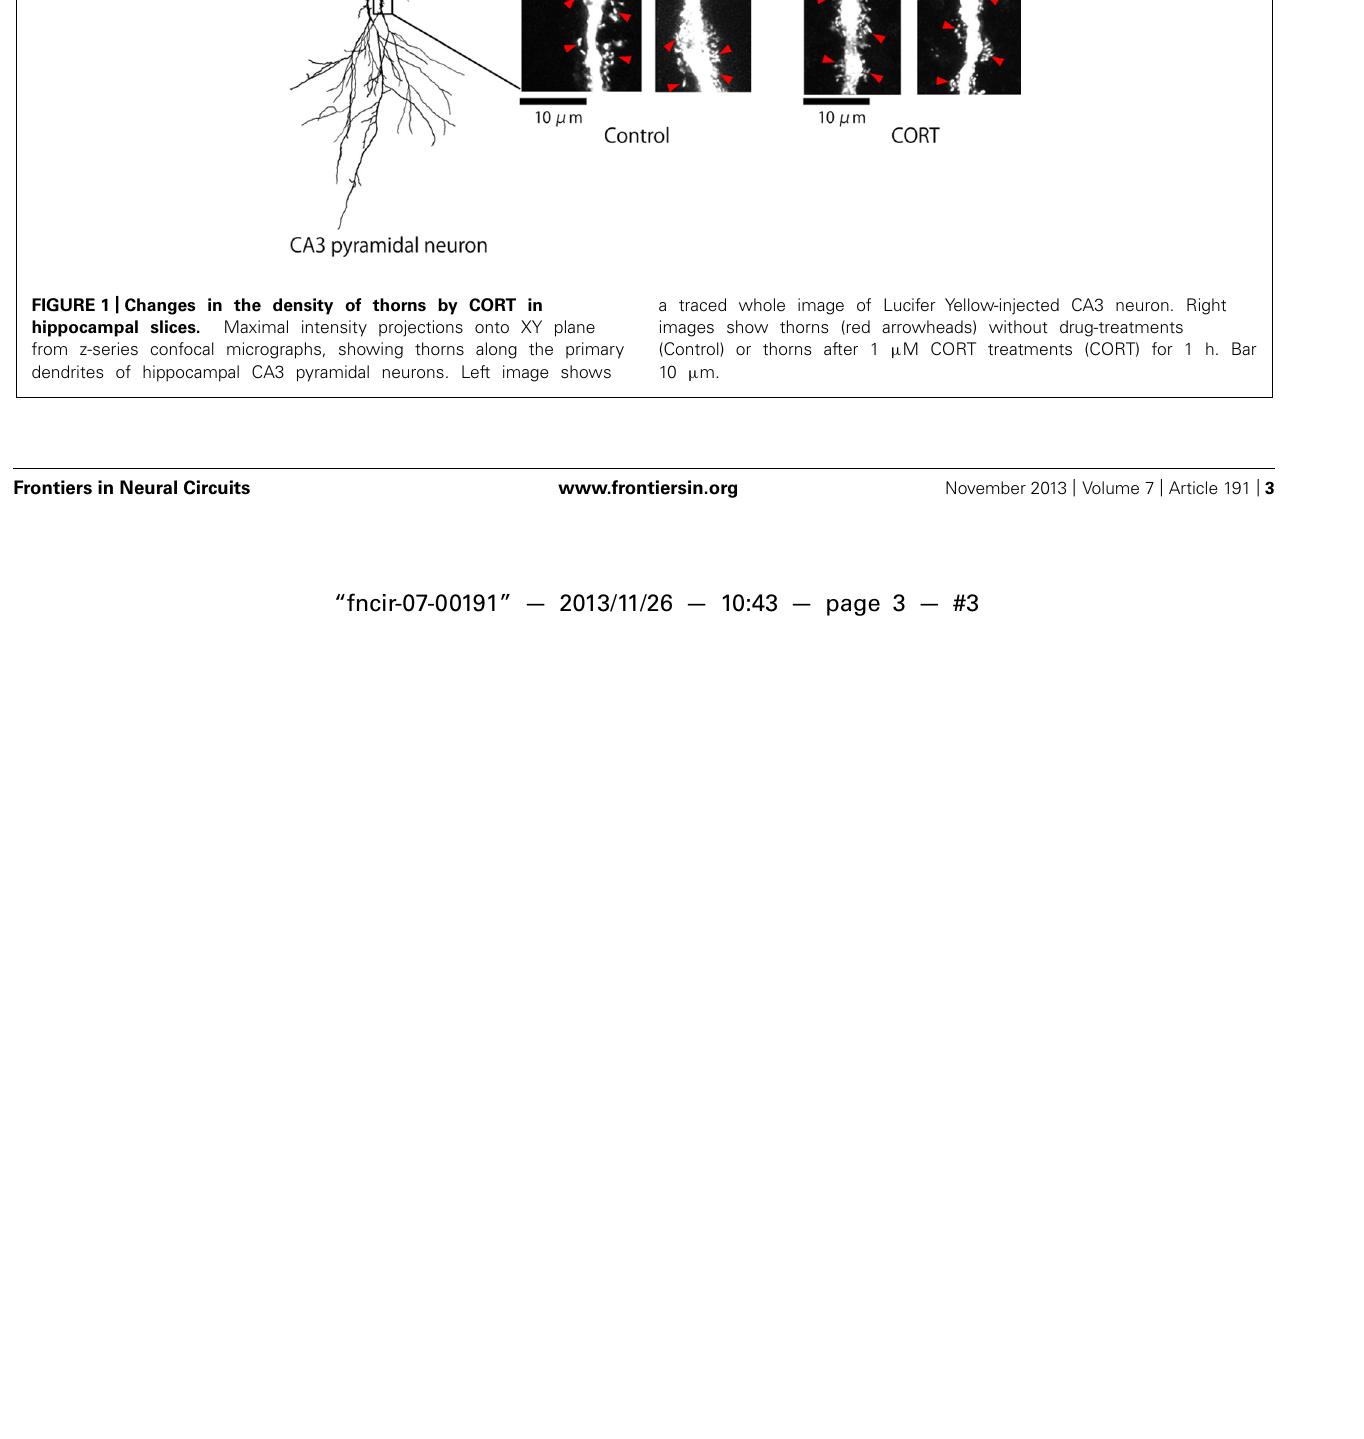
FIGURE 1 | Changes in the density of thorns by CORT in hippocampal slices. Maximal intensity projections onto XY plane from z-series confocal micrographs, showing thorns along the primary dendrites of hippocampal CA3 pyramidal neurons. Left image shows